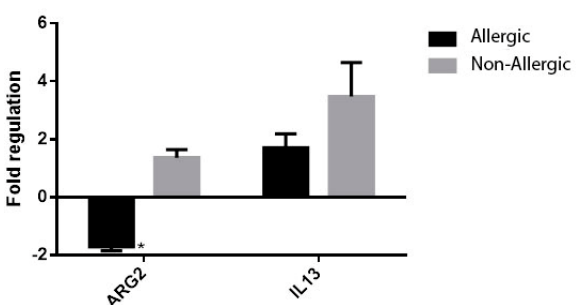
Figure 7. ARG2 and interleukine-13 (IL-13) expression in patients with chronic rhinosinusitis (CRS): allergic vs. non-allergic, * p = 0.003.